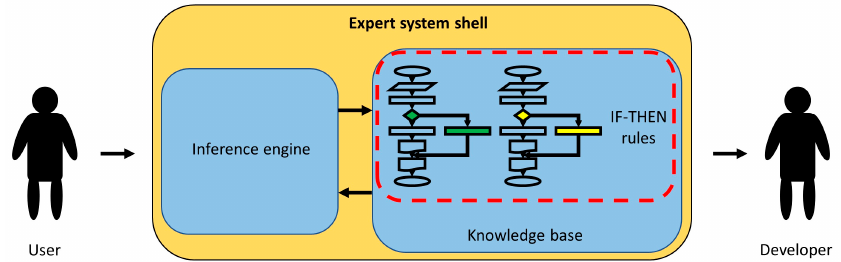
Figure 16 . Generic structure of an ES. Adapted from [39].